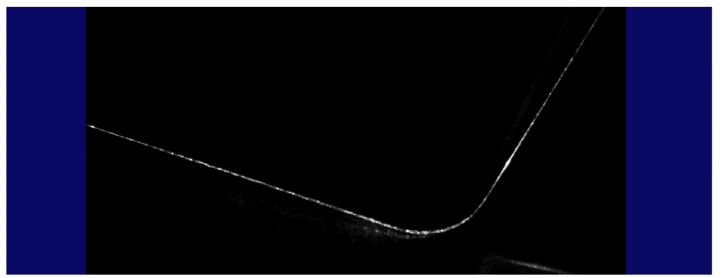
Figure 11. The image was recorded by the inspection system.